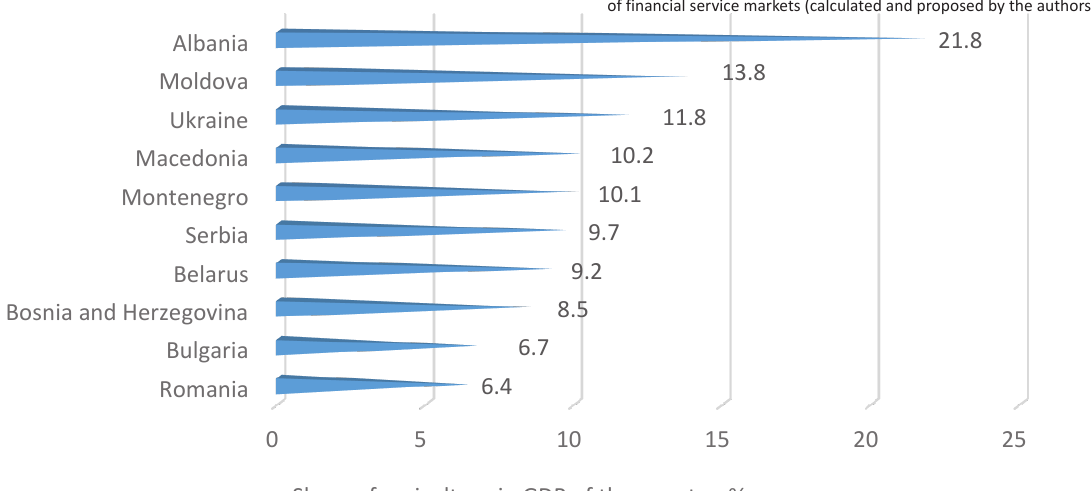
Figure 2. Share of agriculture in GDP of the most developed European countries in the field of agricultural production (in 2017)